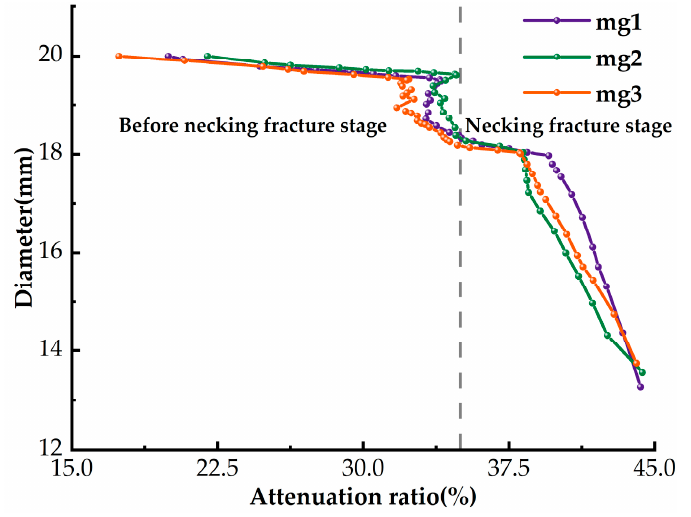
Figure 13. Diameter-stress wave energy attenuation ratio curve in bolt necking position during bolt tensioning.